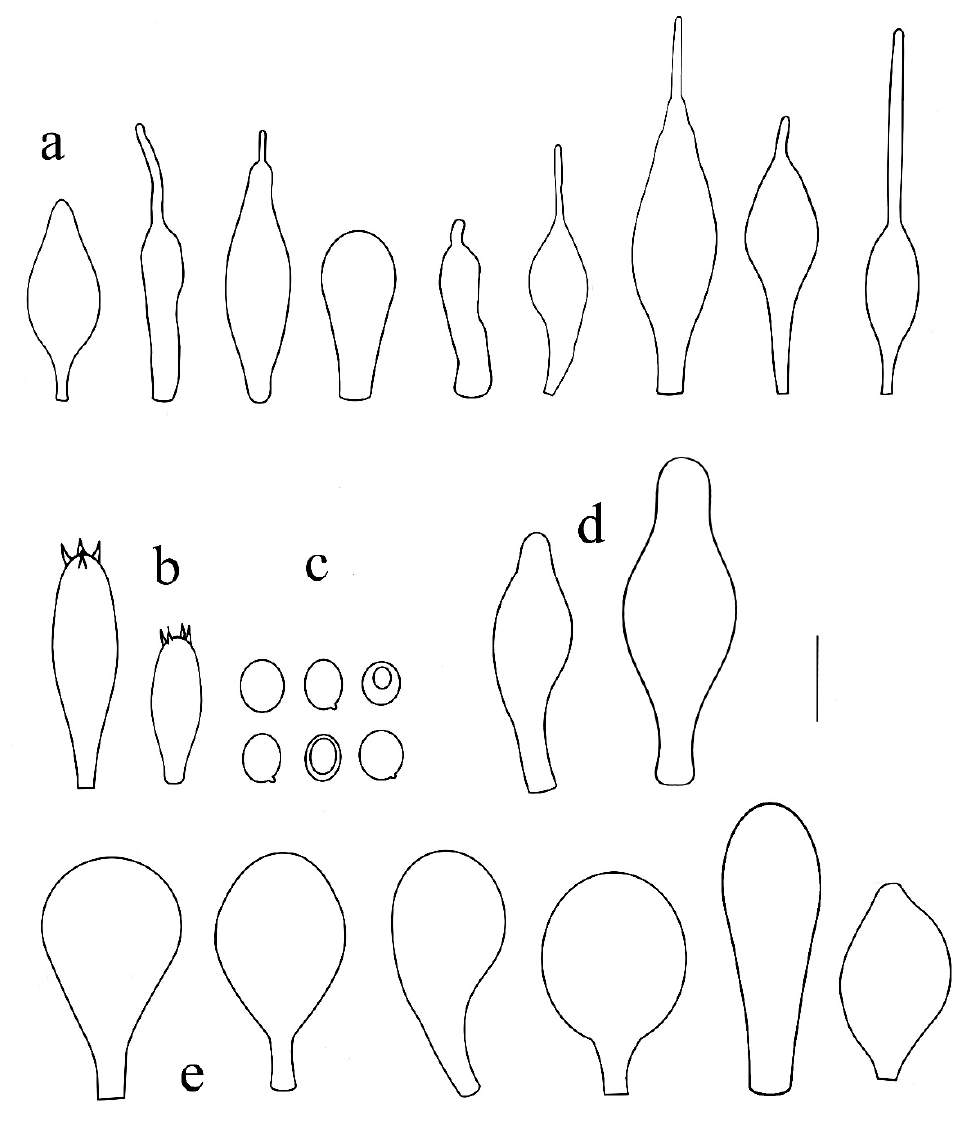
Figure 3. Pluteus insidiosus holotype L0053623. ( a ) cheilocystidia, ( b ) basidia, ( c ) spores, ( d ) pleurocystidia, ( e ) pileipellis elements. Scale bar 10 µm.